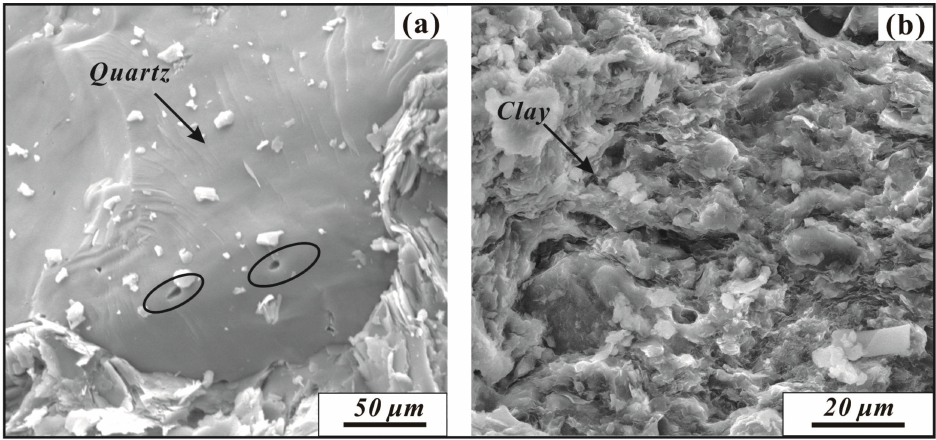
Figure 10. SEM images of quartz and clay minerals in marine Taiyuan shale samples: ( a ) quartz has fewer pores with a smooth surface, ( b ) irregular surfaces and a larger number of pores in clay minerals can be